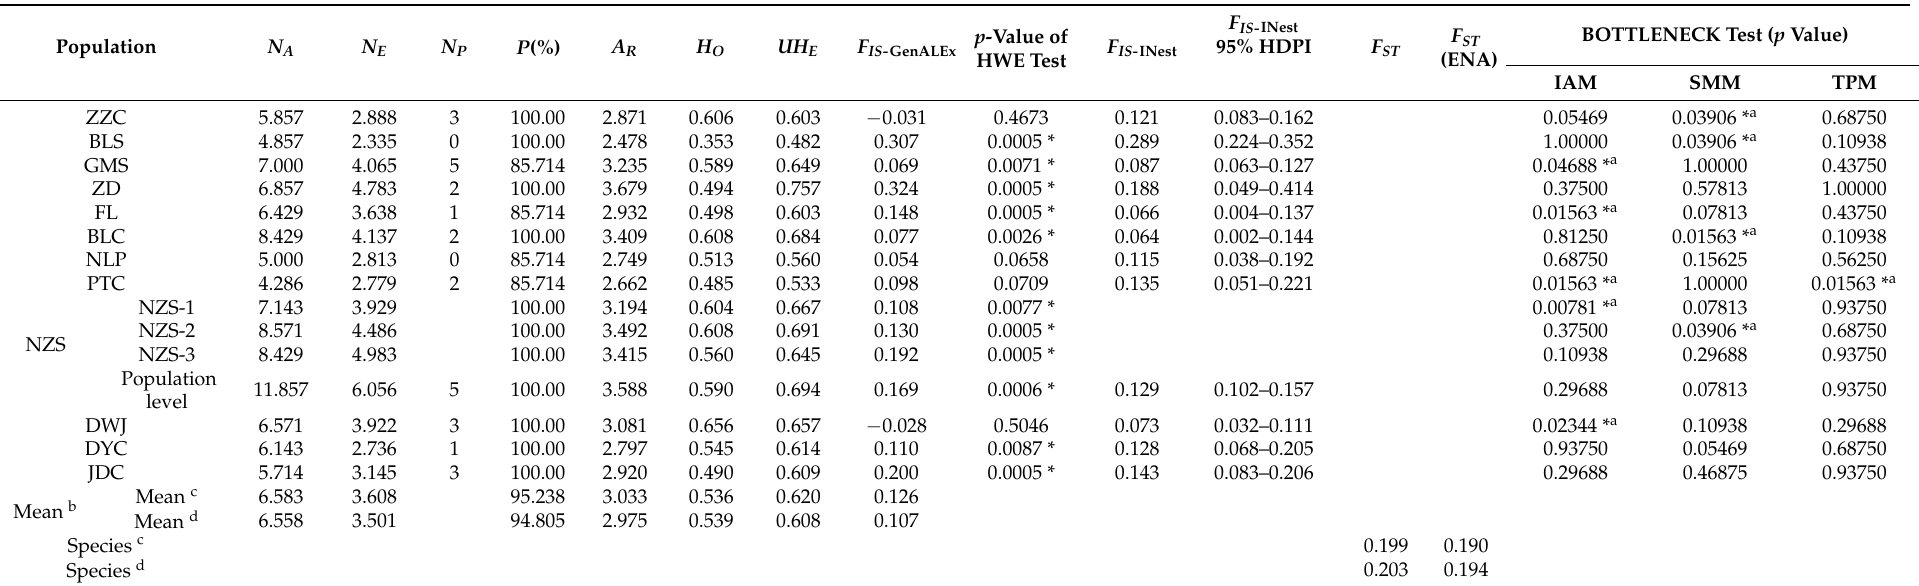
Table 2. Genetic variation and test of bottleneck effects for Camellia nitidissima